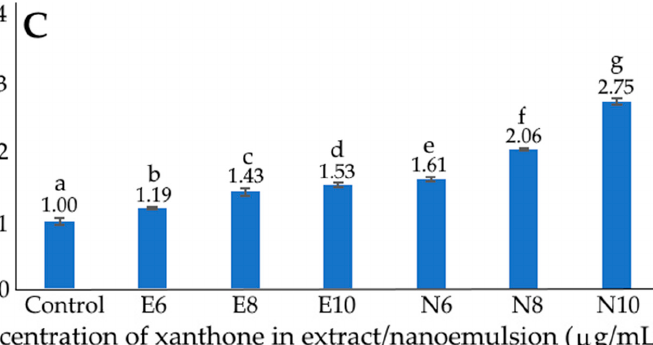
Figure 10. Effect of xanthone extract and nanoemulsion on caspase-3 ( A ), caspase-8 ( B ) and caspase- 9 ( C ) activities of liver cancer cells HepG2. E6, E8 and E10 represent xanthone extract concentrations at 6, 8 and 10 μ g/mL, respectively, while N6, N8 and N10 represent xanthone nanoemulsion con- centrations at 6, 8 and 10 μ g/mL. Data shown are mean ± standard deviation (n = 3) and data with different small letters (a–g) are significantly different at p < 0.05.